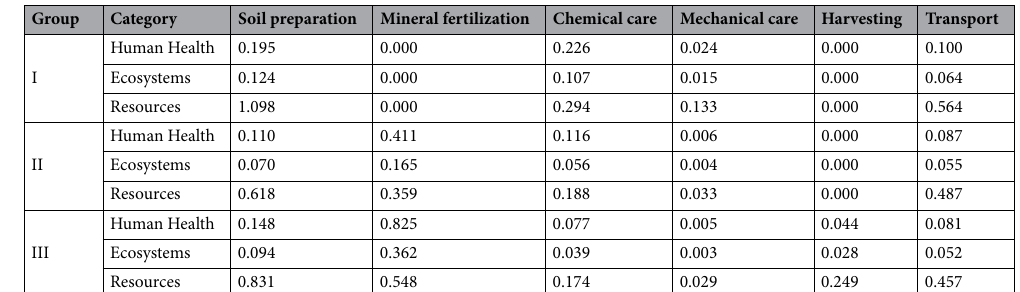
Table 12. The environmental impact of the consumption of production materials as per biomass yield (Pt·tonne −1 ).